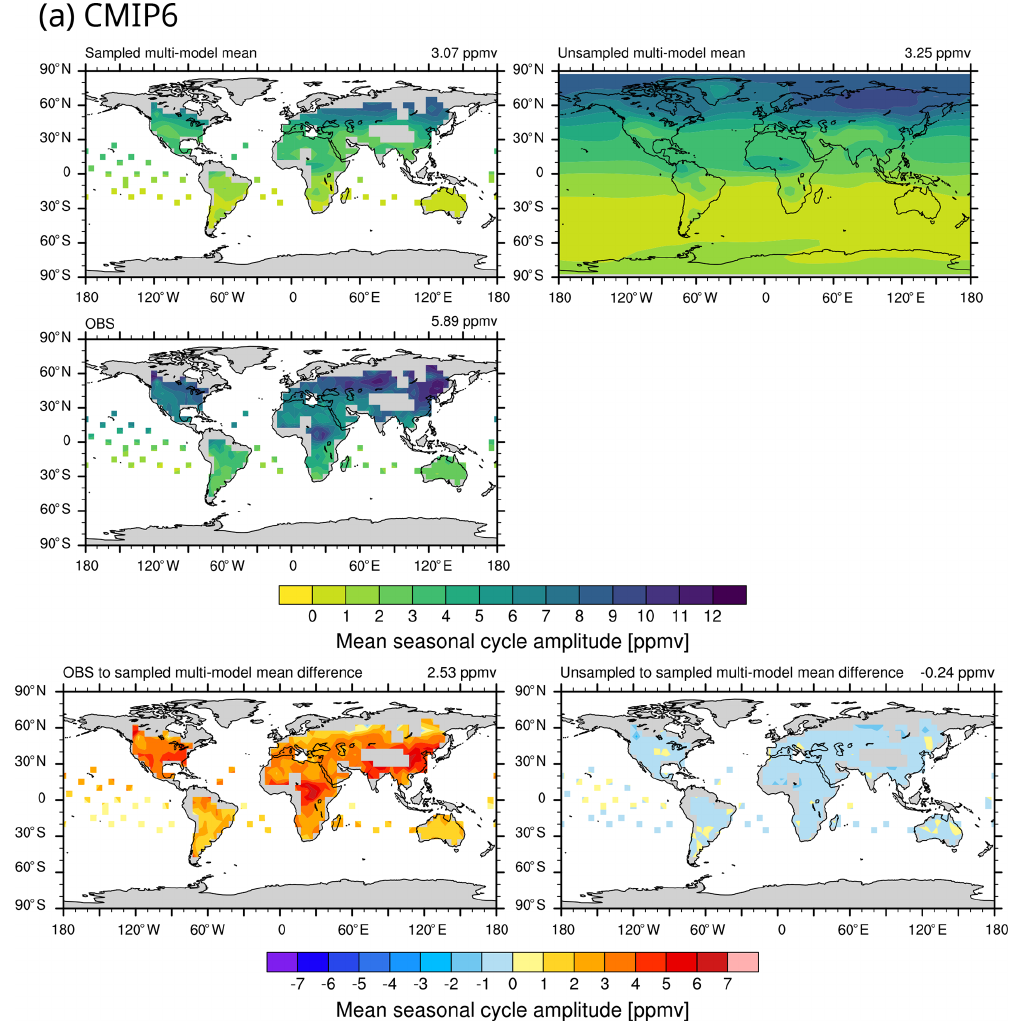
Figure 6. (a) Maps of mean SCA of the CMIP6 multi-model mean for 2003–2014. Top: SCA of multi-model mean with observational sampling (left) and without sampling (right). Middle: SCA of the satellite observations. Bottom: difference between observations and sampled model data (left) and sampled and unsampled model